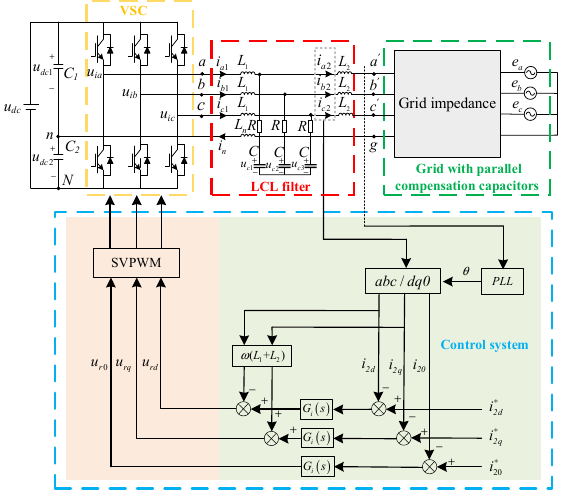
Figure 1. Equivalent control diagram of LCL-TFSCI connected to the grid. To deduce the equivalent impedance of LCL-TFSCI, a small-signal mathematical model of the inverter is established as follows. According to Figure 1, the Kirchhoff volt- age equation for the control loop of the inverter side can be expressed as: